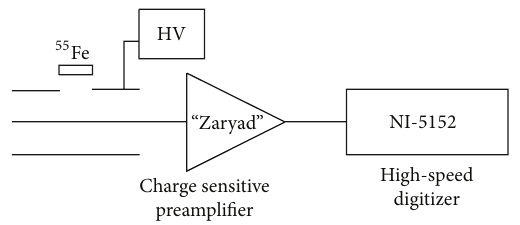
Figure 5: A schematic of the detection concept.